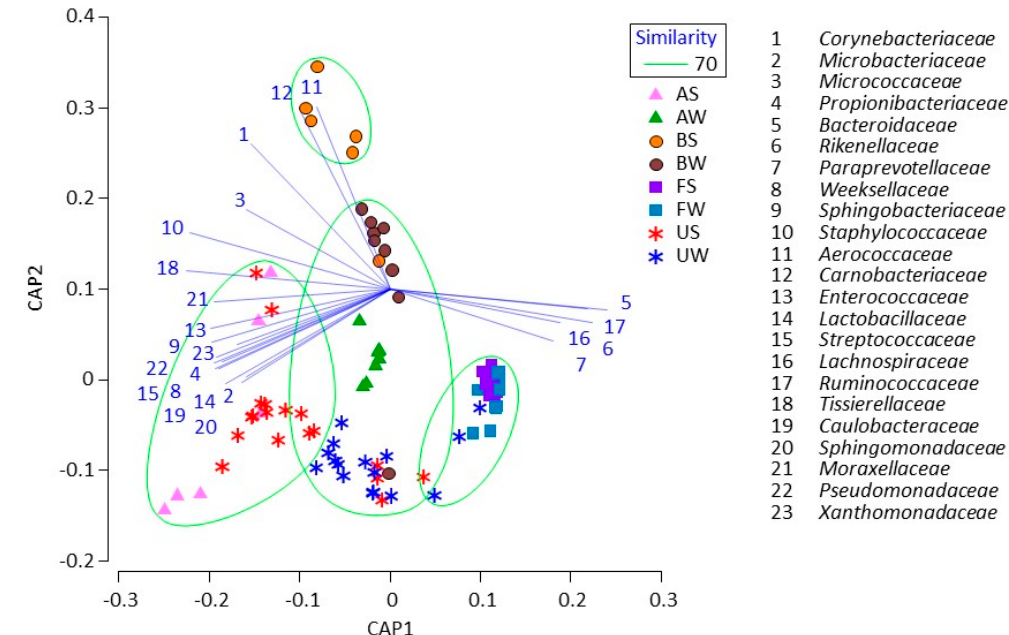
Figure 2. Canonical analysis of principal coordinates plot characterizing the uterine, fecal, bedding, and airborne dust microbiota in the dairy farm. Samples enclosed in a green circle are regarded to be in the same group at a 70% similarity level. Lines indicate discriminant vectors, with a Pearson correlation > 0.7, and the bacterial families in the groupings.